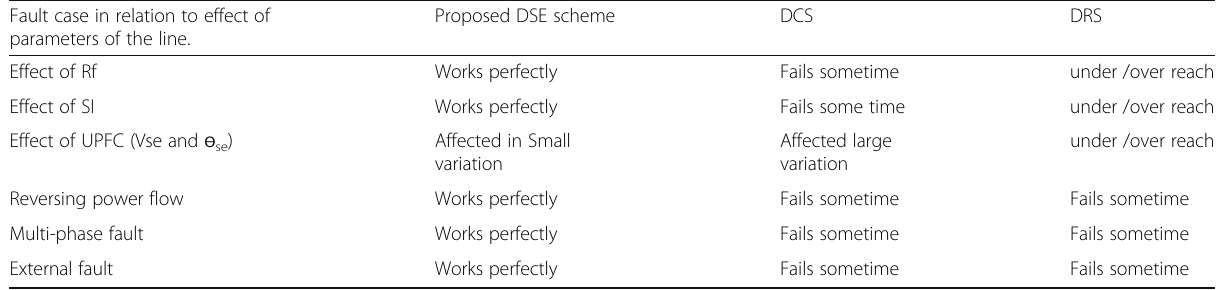
Table 5 A Comparison of proposed DSE scheme with conventional differential current scheme (DCS) and distance relaying scheme (DRS) Fault case in relation to effect of parameters of the line.